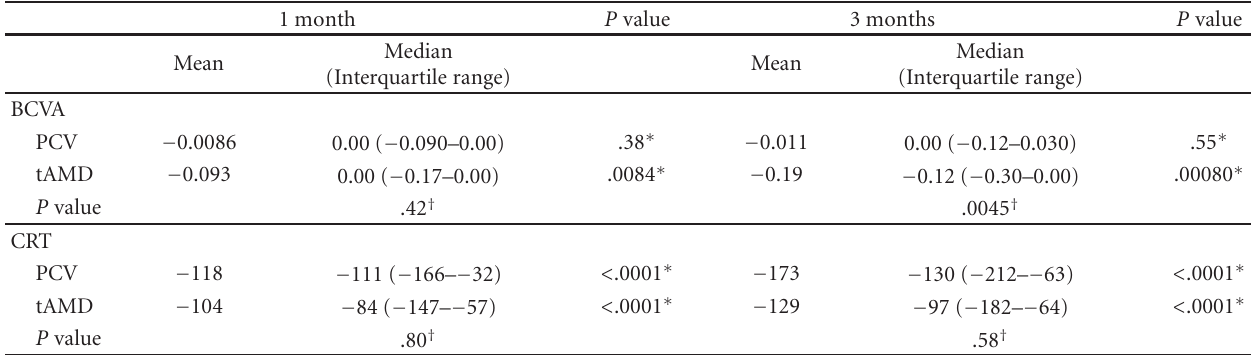
Table 2: Changes in the BCVA and CRT from baseline after IVR treatment in tAMD and PCV patients. 1 month